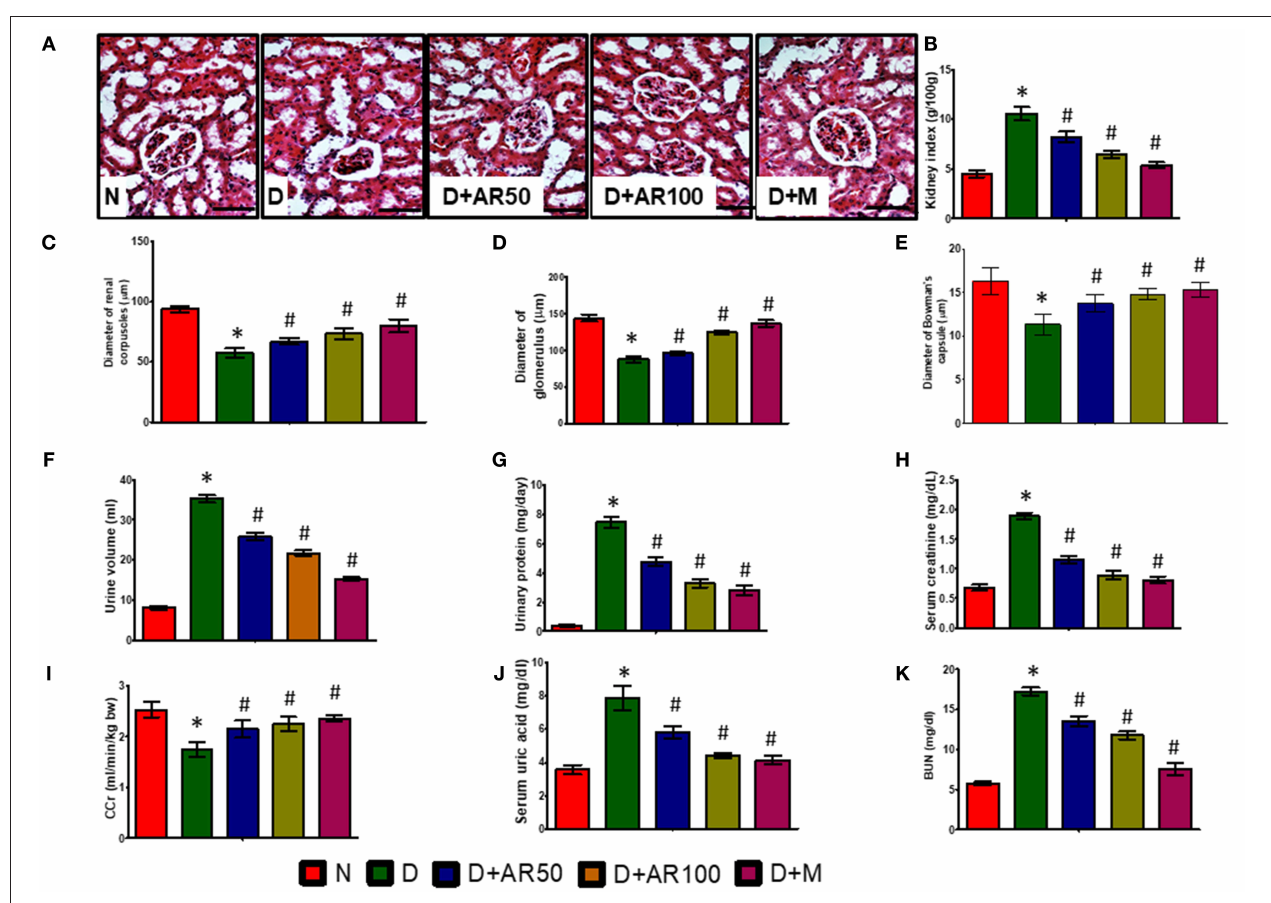
FIGURE 4 | Effect of Annona reticulata L on (A) Histology of kidney (B) kidney tissue somatic index (C) Diameter of renal corpuscles (D) Diameter of glomerulus (E) Diameter of Bowman’s capsule (F) Urine volume (G) Urinary protein (H) Serum creatinine (I) Creatinine Clearance (CCr) (J) Serum uric acid (K) Blood urine nitrogen (BUN). Each value is mean ± SD of six rats in each group.*significant compared to normal control group p < 0.01. # significant compared to diabetic group p <